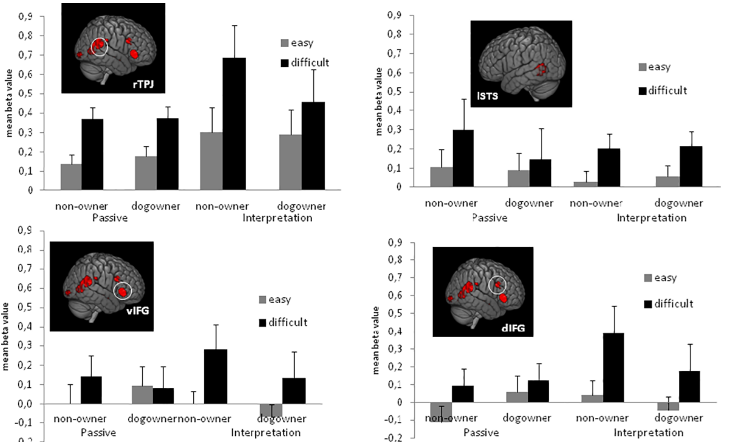
Fig 1. Mean beta values for easy and difficult trials in the rTPJ (57–551), lSTS (-60–557), vIFG (51 32 1) and dIFG (45 20 19) during the passive and the interpretation task for participants who do not own a dog and participants who own a dog. Brain activationsare taken from the localizertask at p < 0.001 uncorrected. To correct for multiple comparisons a cluster-level extent thresholdwas appliedat p < 0.05 (FWE cluster corrected